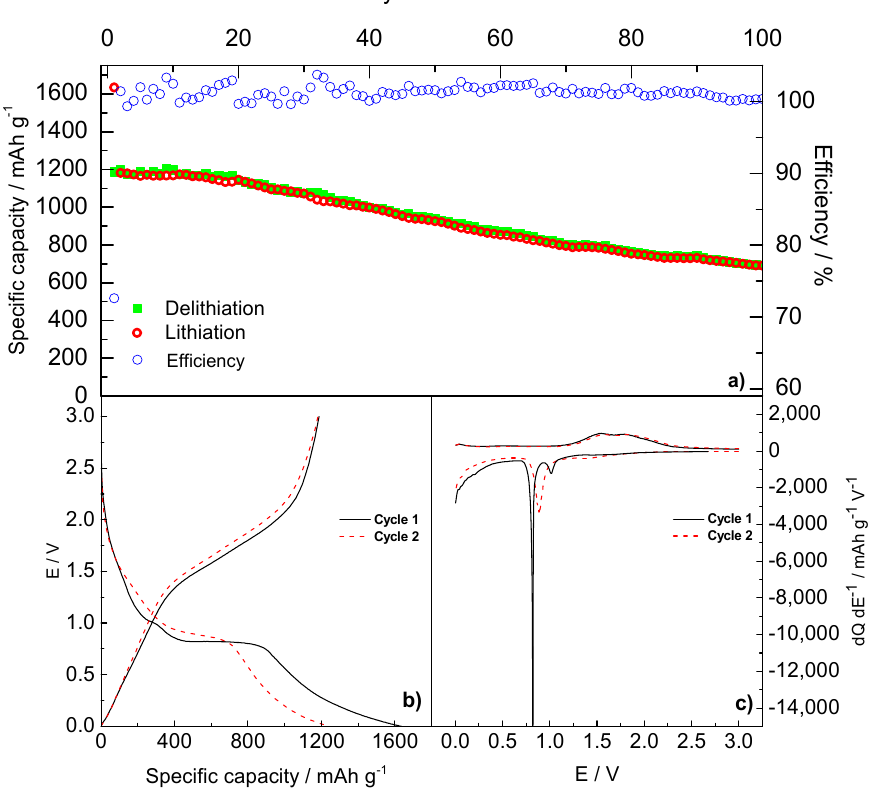
Figure 5. ( a ) Galvanostatic cycles at 1C-rate of Fe 3 O 4 /rGO, ( b ) galvanostatic E vs. Q profile of the first 2 cycles, ( c ) differential dQ dE − 1 profile. The test was performed at 1C-rate (881 mA g − 1 ) and in the potential window within 0.001–3.000 V.